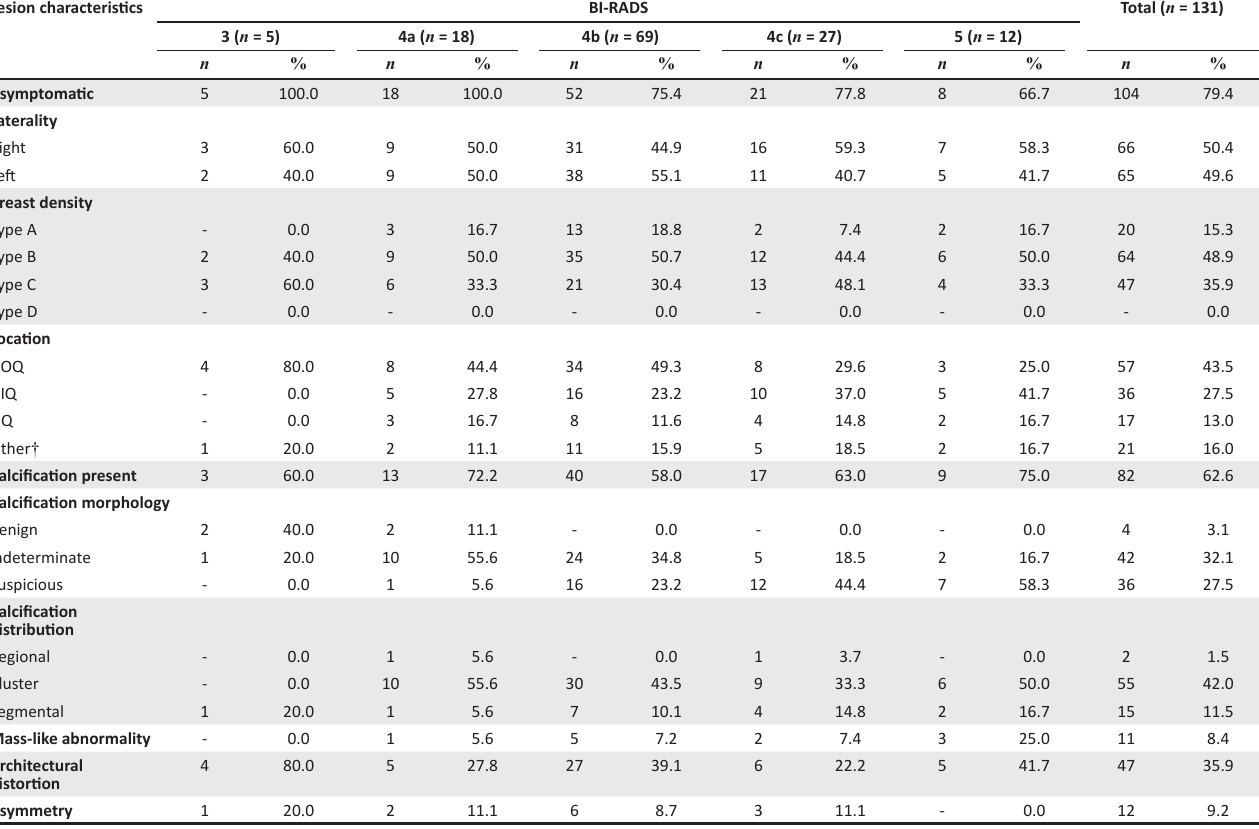
TABLE 1: Lesion characteristics as per breast imaging reporting and data system category of the stereotactic breast biopsies. Lesion